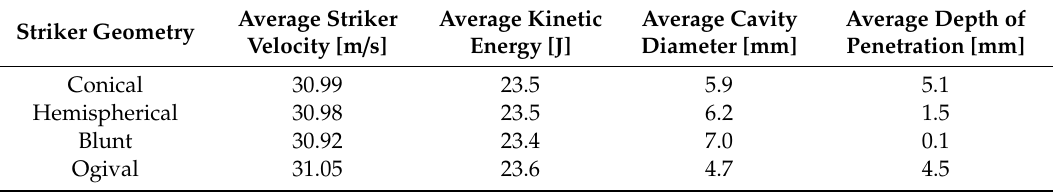
Table 3. Average experimental results, depending on striker geometry.